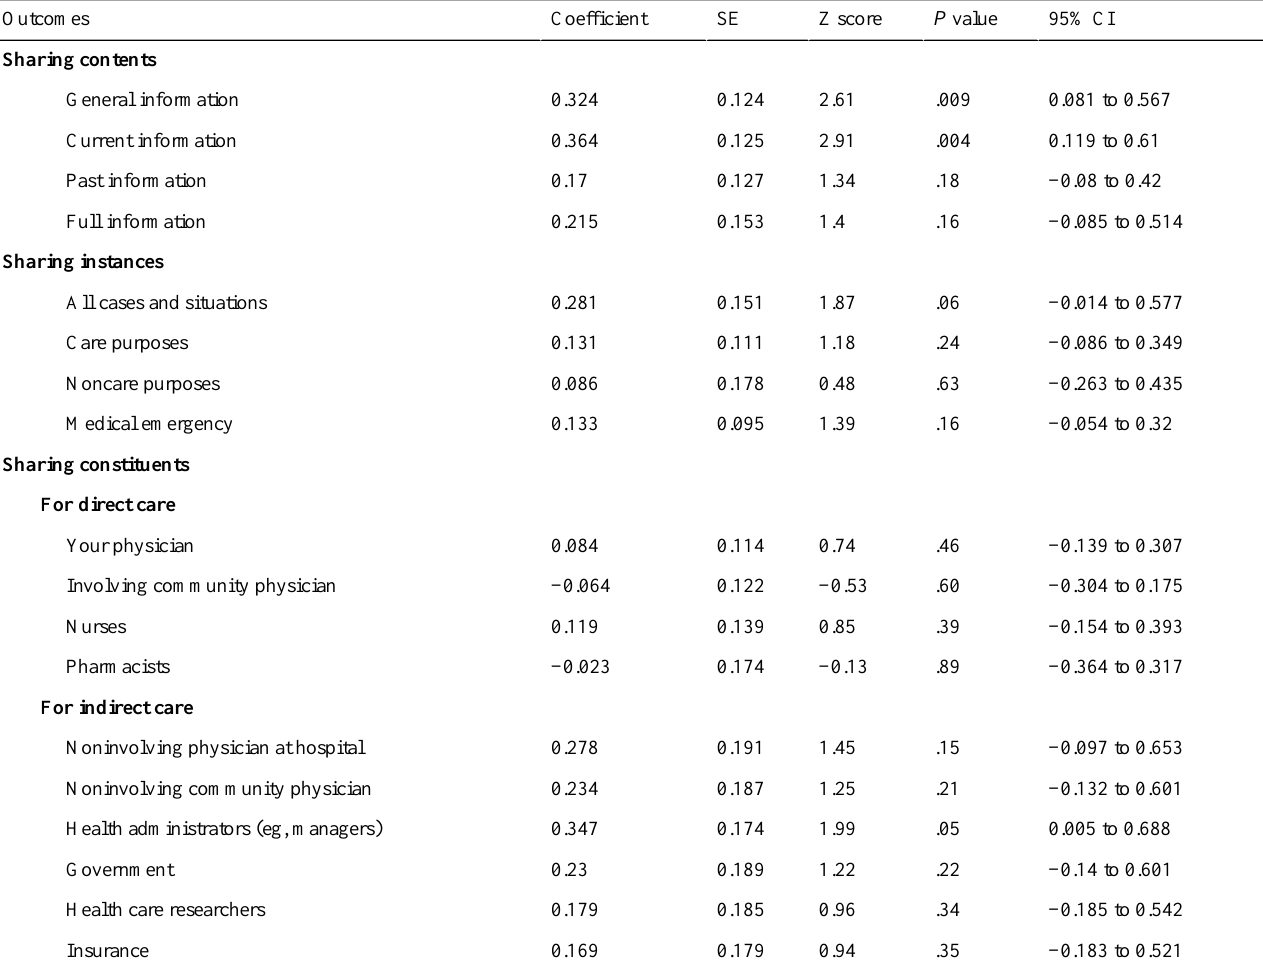
Table 4. Average treatment effect of daily internet banking use for matched pair